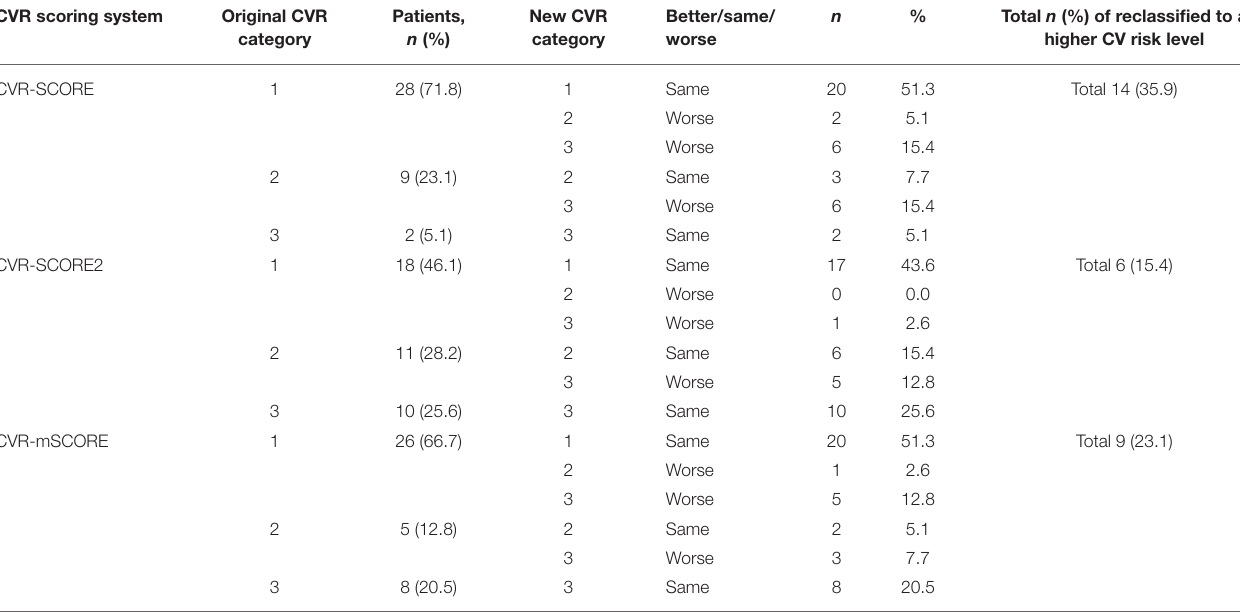
TABLE 6 | Reclassification of the original cardiovascular risk category in IIM based on SCORE, SCORE2, and mSCORE to the cardiovascular risk category based on subclinical atherosclerosis markers on carotid ultrasound examination. CVR scoring system